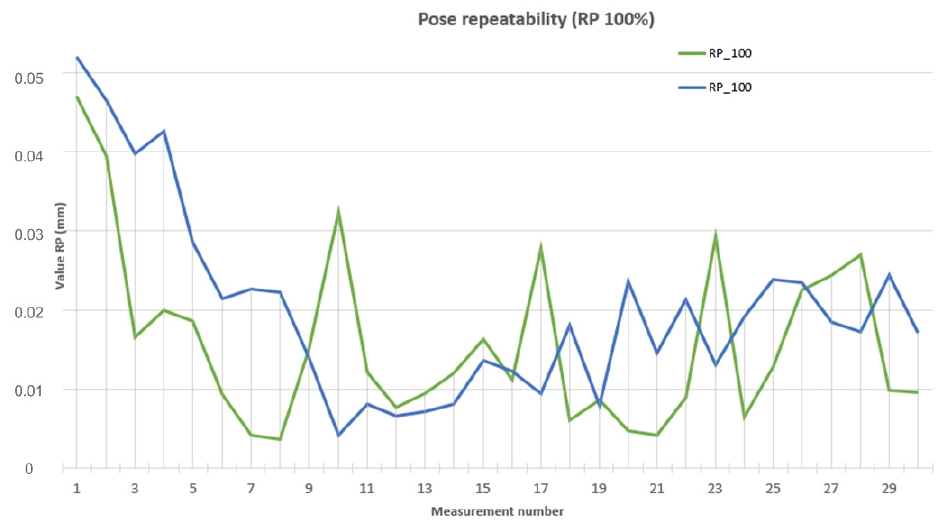
Figure 8. Plotted RP comparison under the full